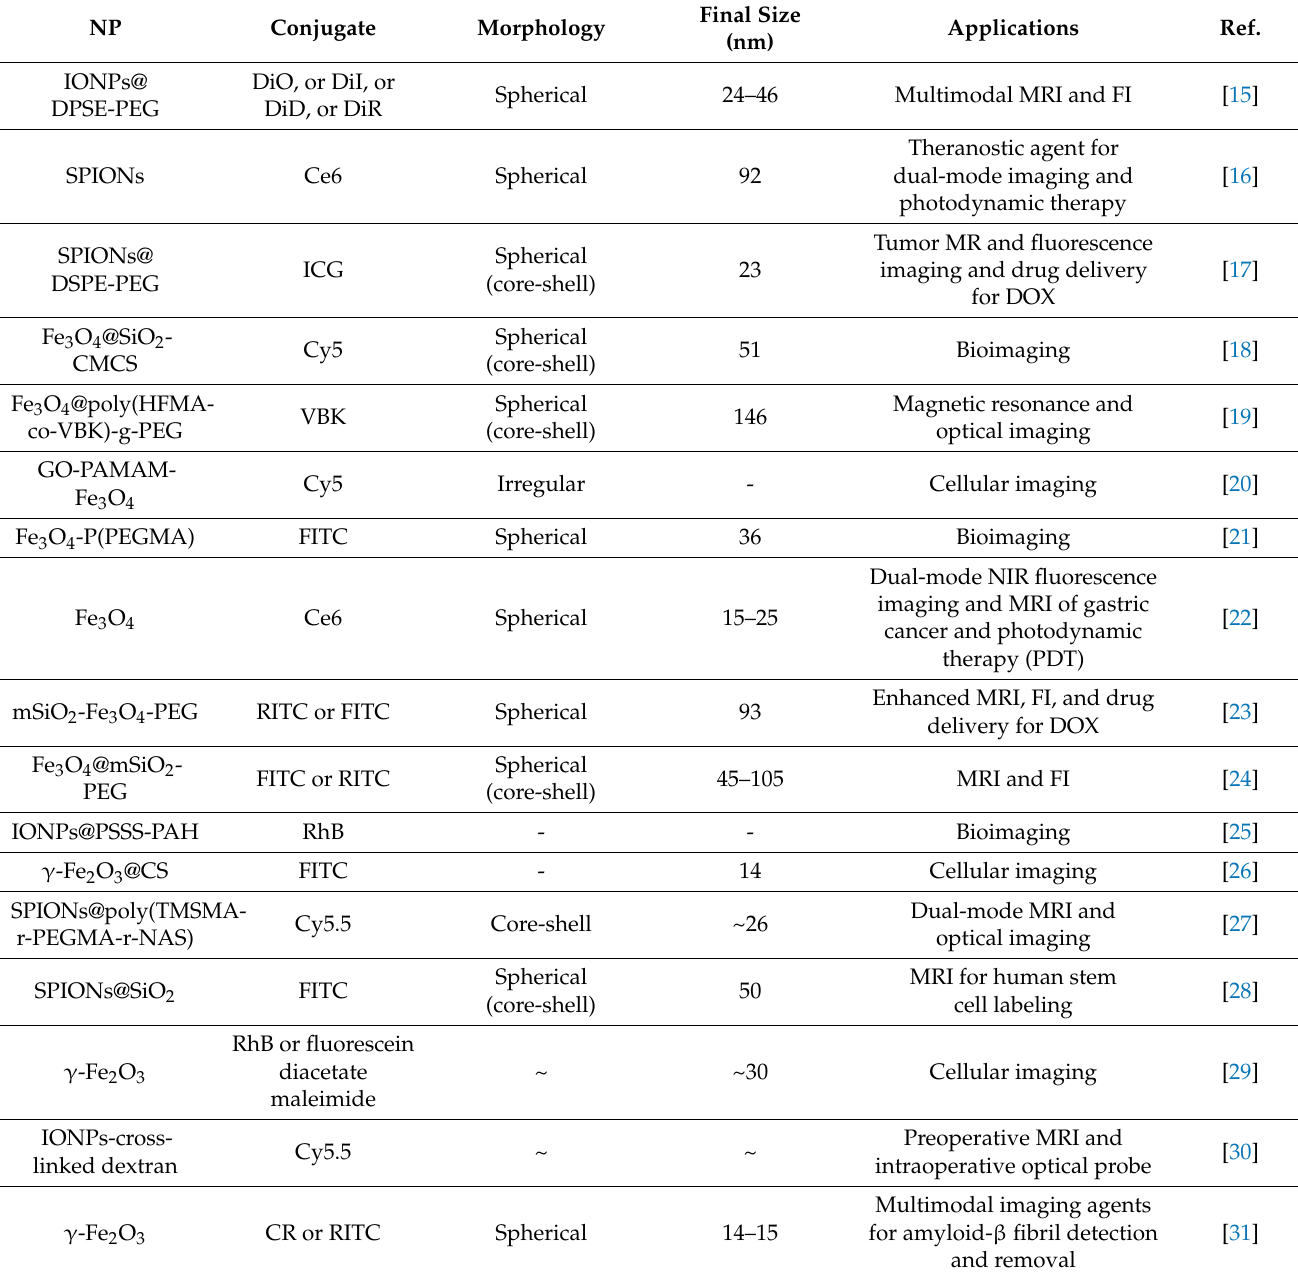
Table 1. Organic dye-integrated magnetic nanoparticles for biomedical